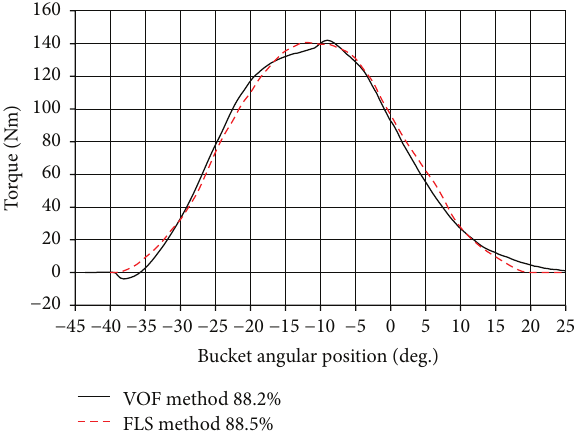
Figure17:ComparisonofVOFandFLSmethodfordifferentrunner design of 18 buckets (from